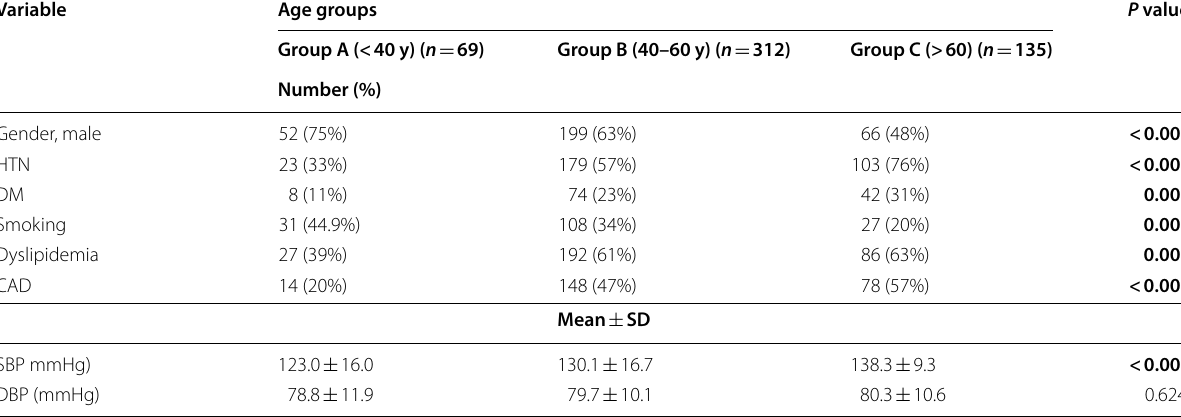
Bold mean significant values that is less than or equal 0.05